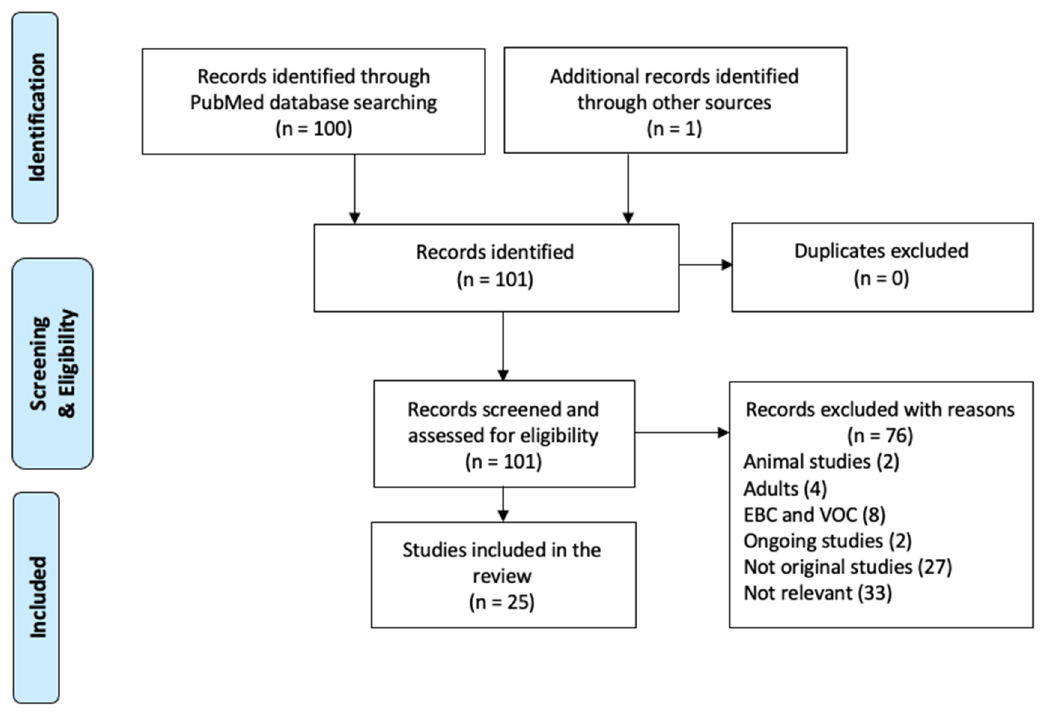
Figure 1. Flowchart of the study selection process.